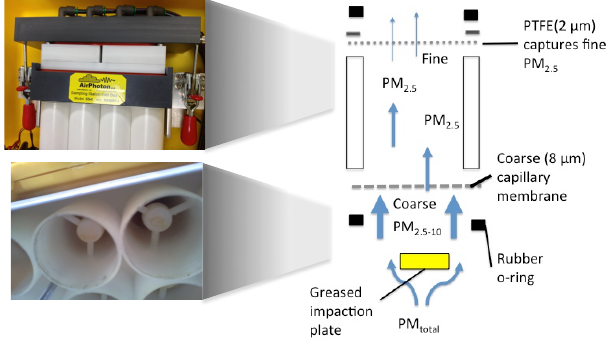
Figure 2. Diagram of AirPhoton filter assembly. The aerosol/air stream first passes through a bug screen followed by a greased impaction plate that removes particulates larger than ∼ 10µm di- ameter. Impaction plates are re-greased prior to loading a new cartridge. The 8µm capillary membrane filter then traps coarse PM c ≡ (PM 10 –PM 2 . 5 ) particulates. A 2µm PTFE filter traps fine PM 2 . 5 . Blue arrows indicate the direction of airflow (flow rate is 4Lmin − 1 ). Useable filter diameter on which PM is collected is 19mm, resulting in PTFE and capillary membrane face velocities of 23.5cms − 1 . Capillary porosity is